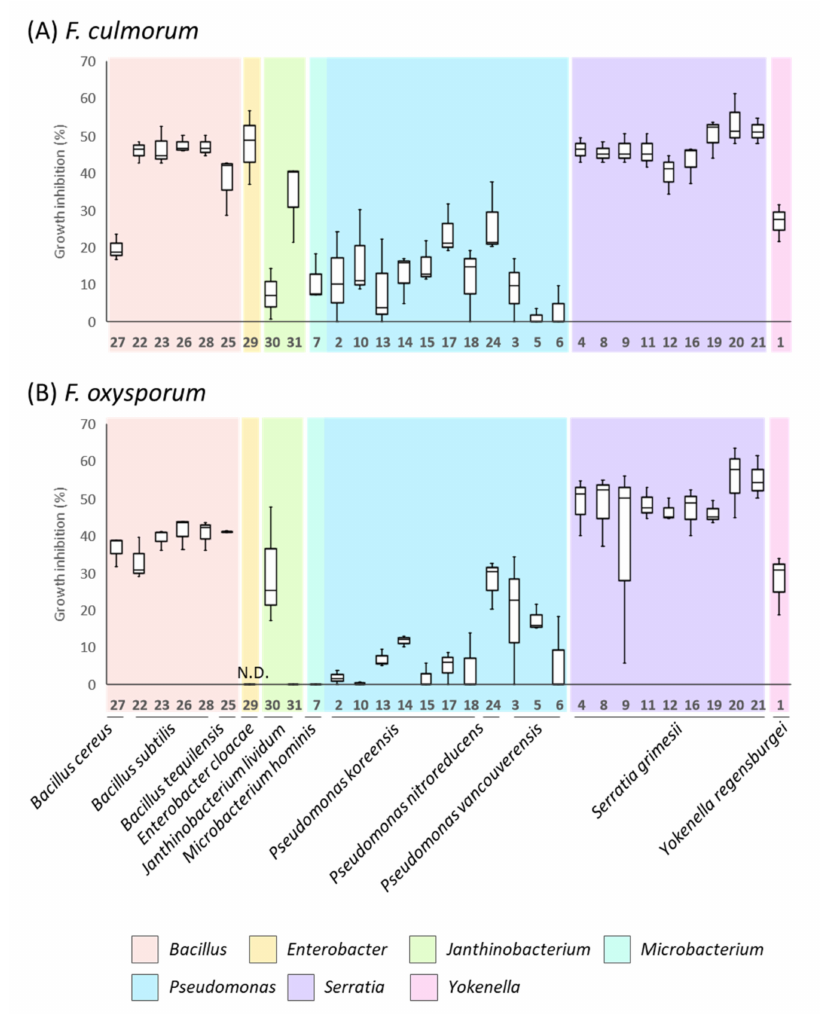
Figure 2. Growth inhibition rate of 31 vetiver bacterial endophytes against F. culmorum (Day 6) ( A ) and F. oxysporum (Day 11) ( B